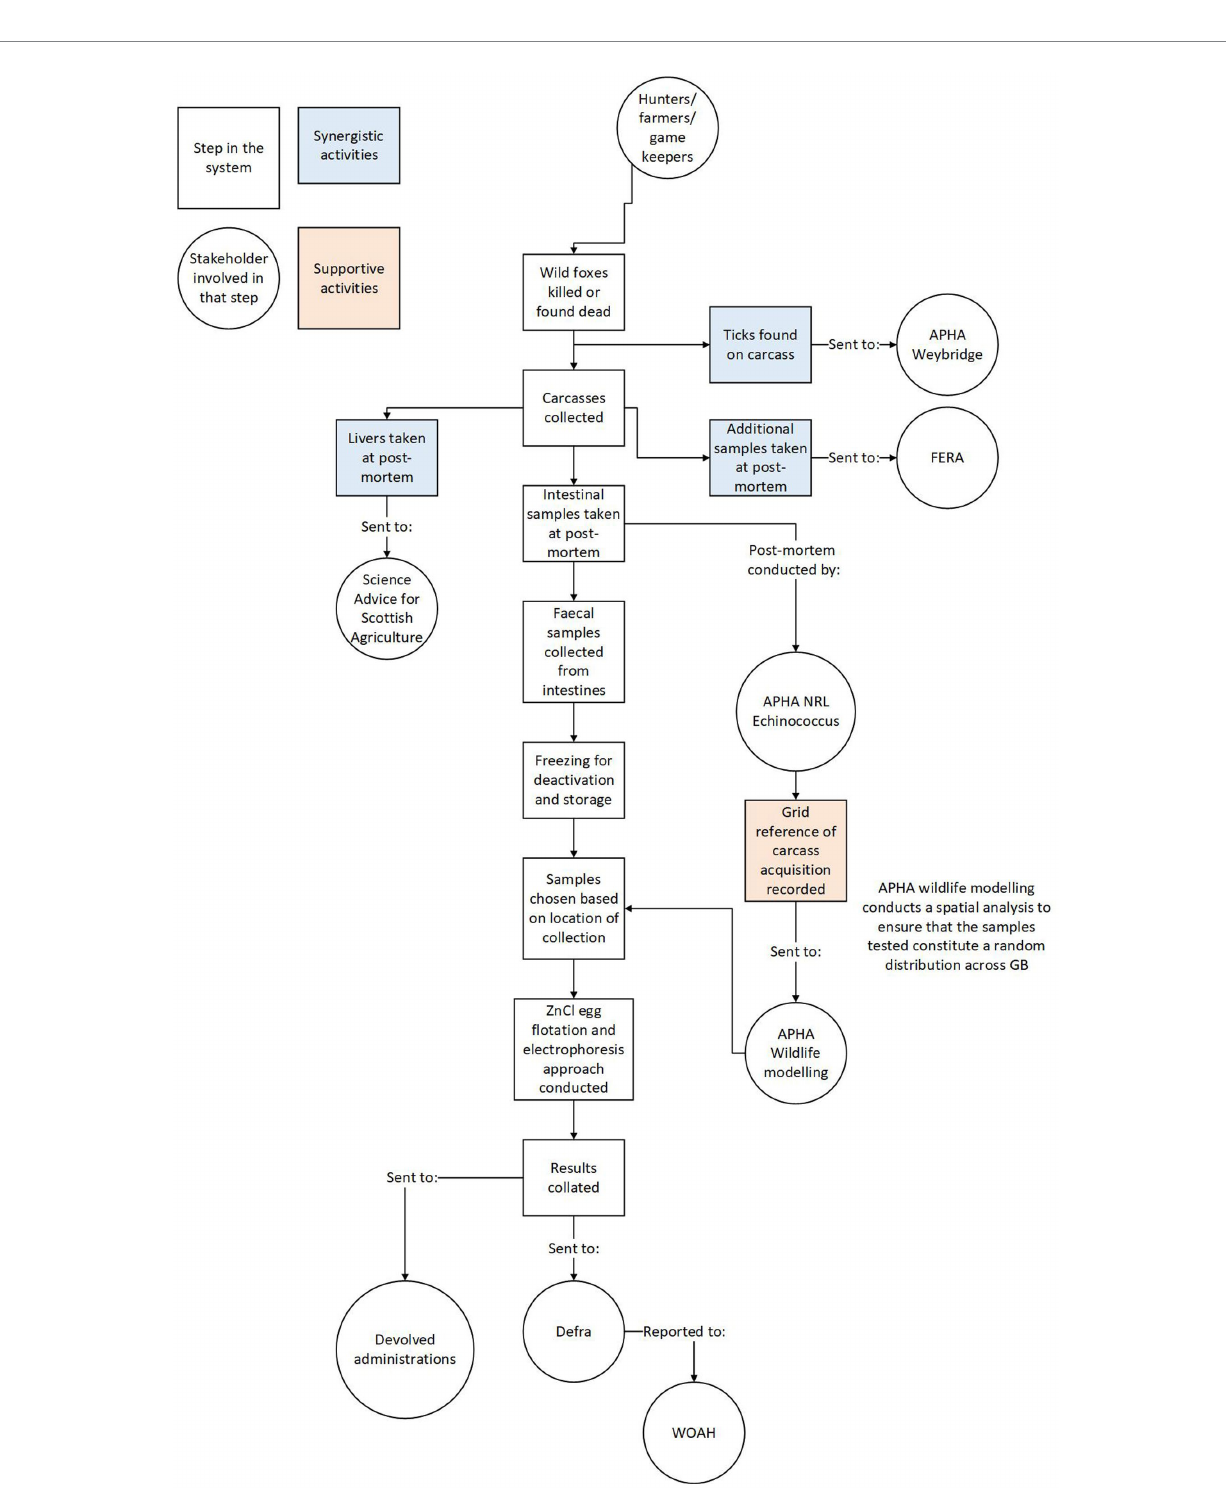
FIGURE 2 Showing the system structure and chronology from carcass collection to result reporting. Rectangles represent steps in the system while circles represent stakeholders involved in relevant